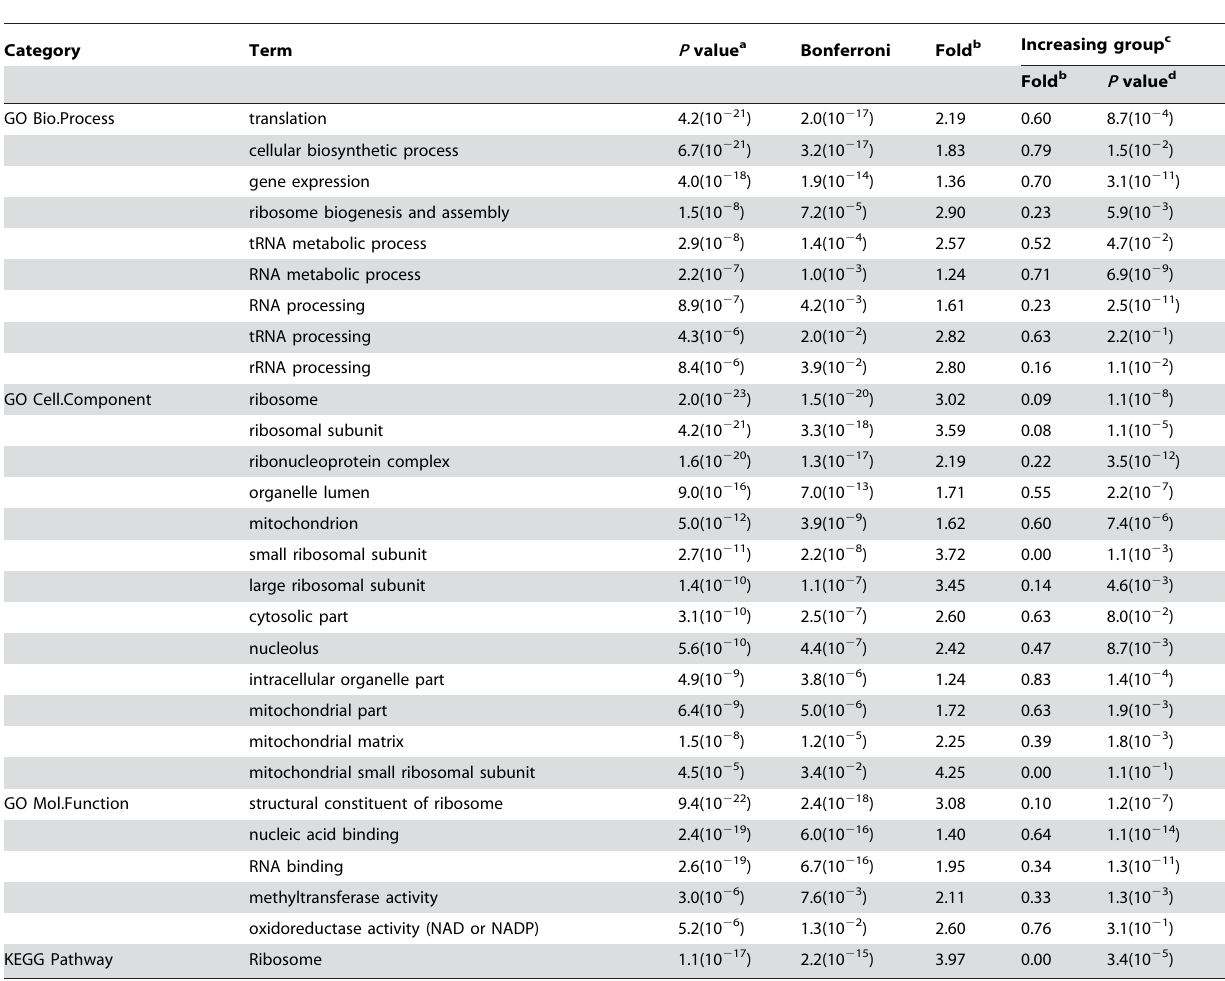
Table 7. Terms in the Gene Ontology and KEGG pathway databases over-represented among genes that decreased expression with advancing age in human lymphocytes (1,878 genes in total 13,232).